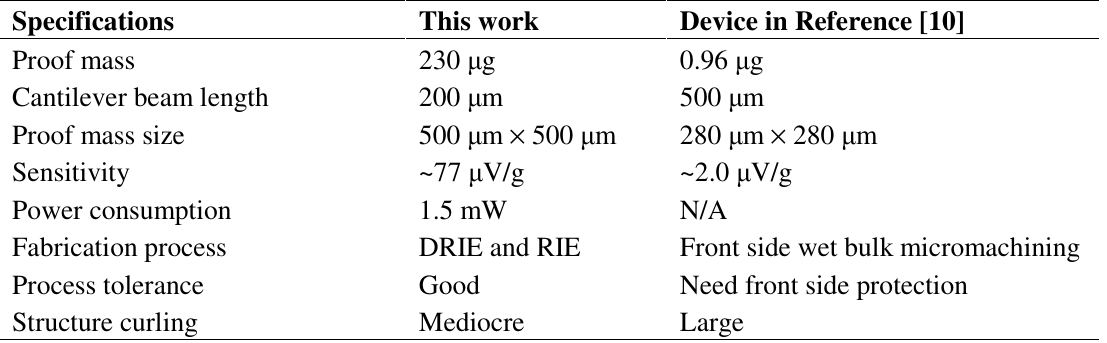
Table 4. Summary of the merits of the demonstrated device and comparisons with the device demonstrated in Reference